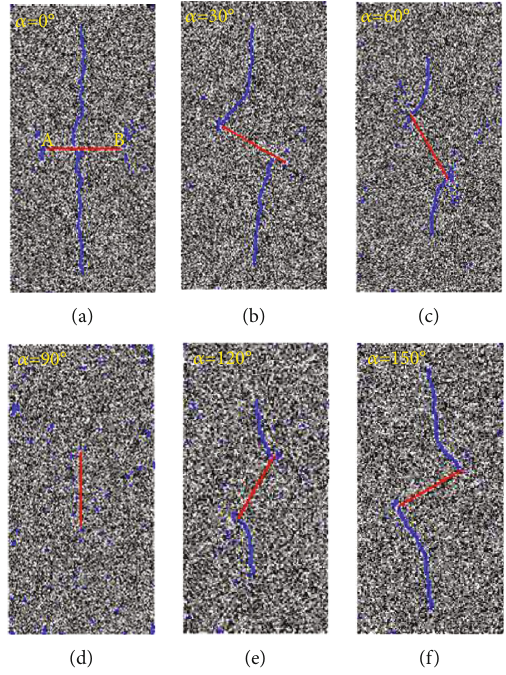
Figure 10: Initial crack propagation of the specimens containing a single